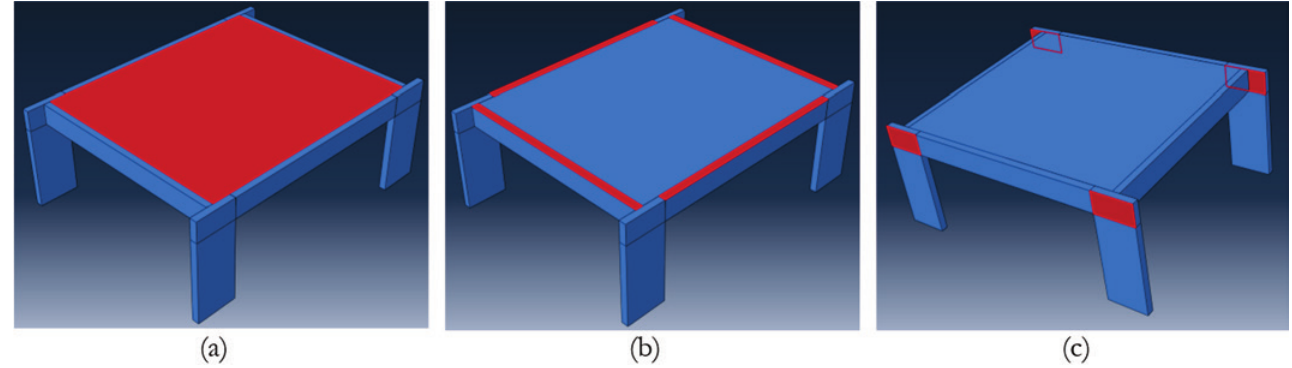
Indicação das superfícies de aplicação de cargas verticais e horizontais sobre os elementos estruturais dos modelos: (a) vertical sobre as lajes, (b) vertical sobre as vigas e (c) horizontal nos